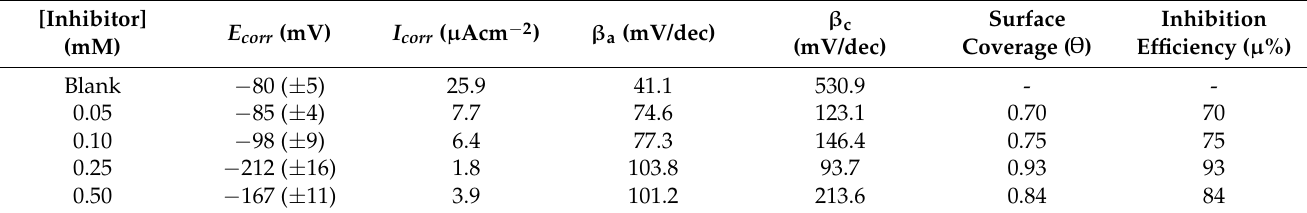
Figure 4. SEM images of brass after immersion in 0.5 M H 2 SO 4 solution ( a ) without any inhibitor for 24 h, 2000 × magnification and ( b ) with 0.25 mM of inhibitor for 24 h, 2000 × Figure 5. Potentiodynamic polarization curves of brass samples with and without corrosion inhibitors in 0.5 M H 2 SO 4 at 25 ◦ C. Table 2. Electrochemical parameters ( E corr , i corr , β a, β c) extrapolated from potentiodynamic polariza- tion curves of brass in 0.5 M H 2 SO 4 with and without corrosion inhibitor.